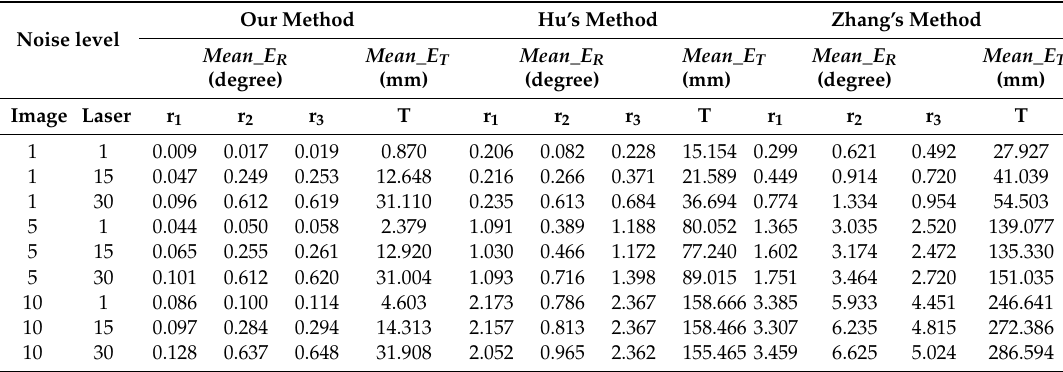
Table 1. Mean of the extrinsic calibration errors under di ff erent noise levels.